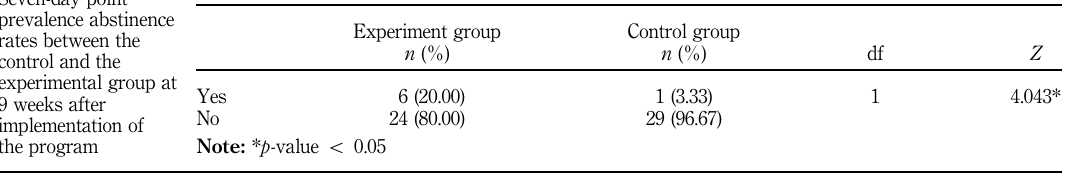
Table II. Seven-day point prevalence abstinence rates between the control and the experimental group